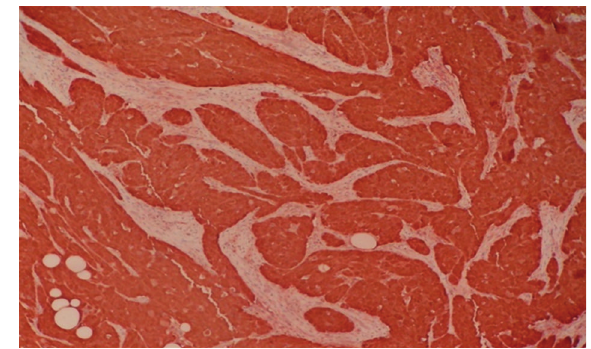
Figure 2: Nests of polygonal cells with eosinophilic cytoplasm divided by fibrous septa (H&E, × 40).